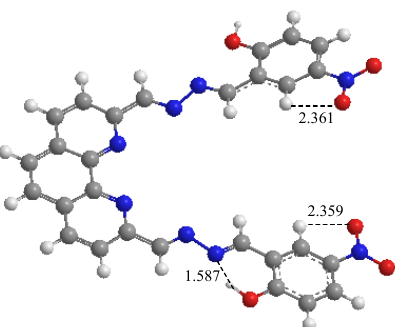
Figure 5. Optimized structure of compound 1